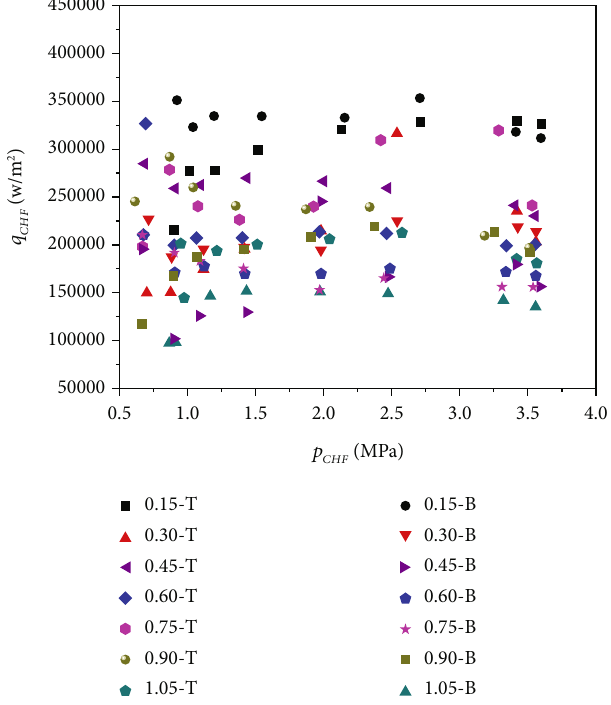
Figure 21: Experimental q